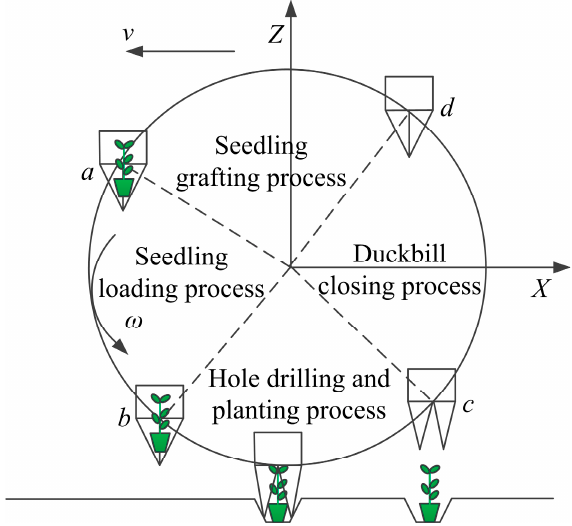
Figure 2. Motion diagram of the planter.